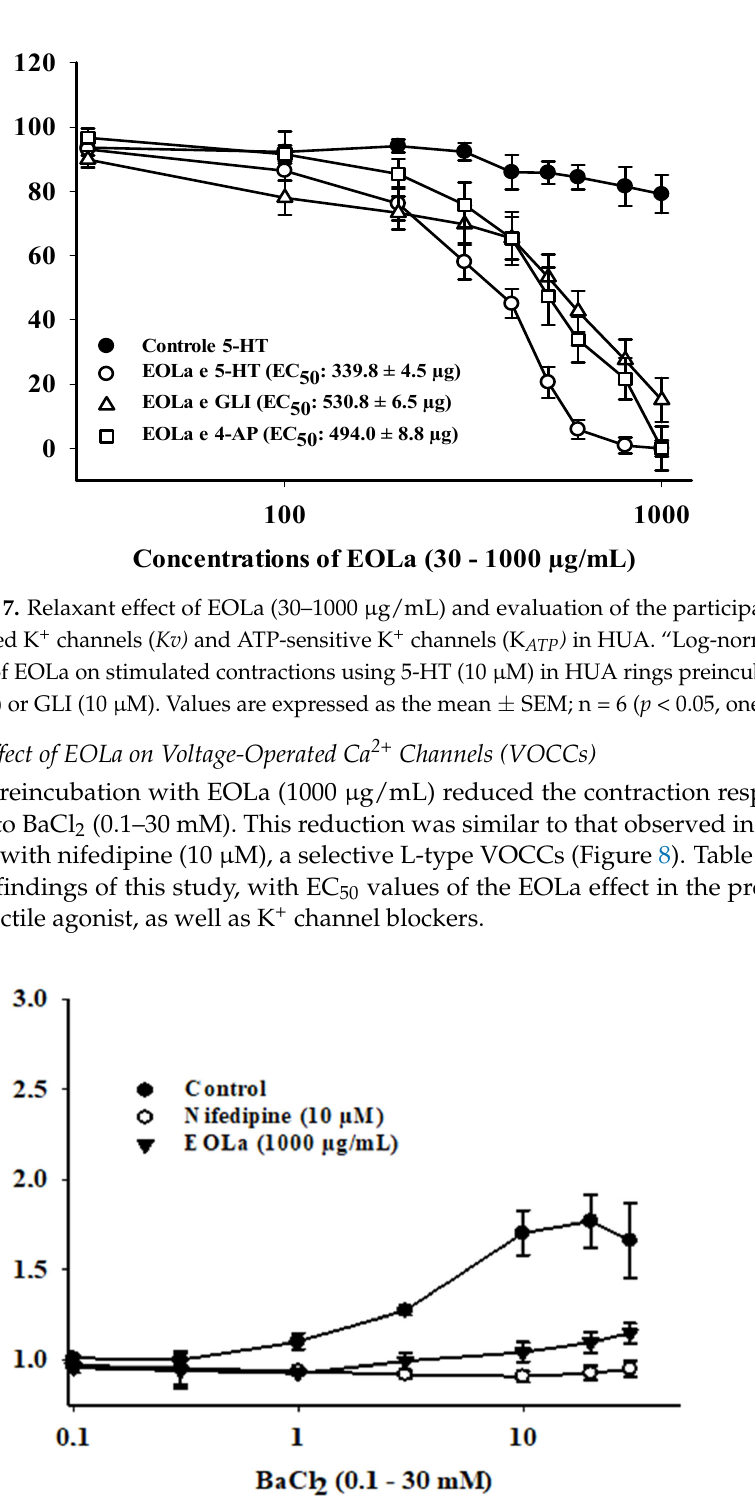
Figure 8. Relaxant effect of EOLa (1000 µ g/mL) and assessment of participation of voltage-operated calcium channels (VOCCs) in HUA. Control: “Log-normal” plot for the contractile effect by cu- mulative addition of BaCl 2 (0.1–30 mM) in HUA preparations. Nifedipine: Graph for inhibitory effect of nifedipine (10 µ M) on induced contraction by cumulative addition of BaCl 2 (0.1–30 mM); positive control. EOLa: Graph for the contraction-blocking effect of EOLa (1000 µ g/mL) on accu- mulative addition of BaCl 2 (0.1–30 mM). Values are expressed as the mean ± SEM; n = 6 ( p < 0.05, one ‐ way ANOVA).